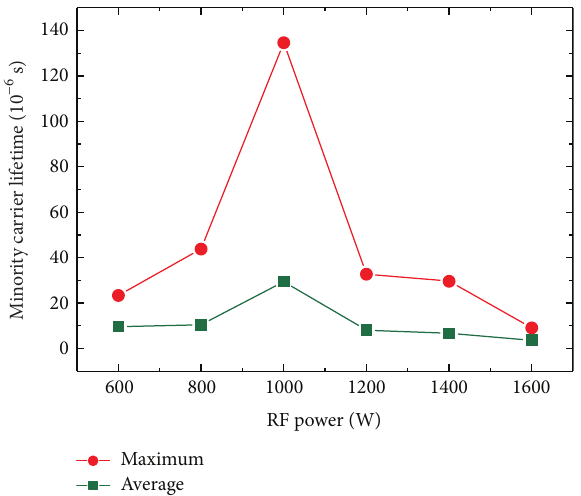
mm CZ wafers passivated by RF magnetron sputtered aluminum C in N ambient. Upper row: minority carrier lifetime mappings. 2 125 × 125 ∘ 2